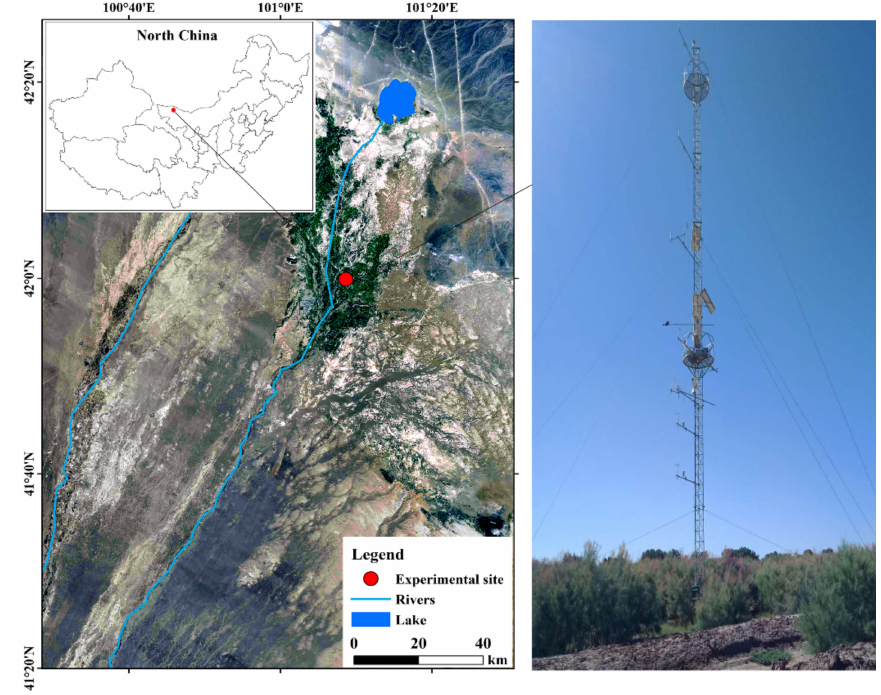
Figure 1. Experimental location and instrumentation setting at the Sidaoqiao